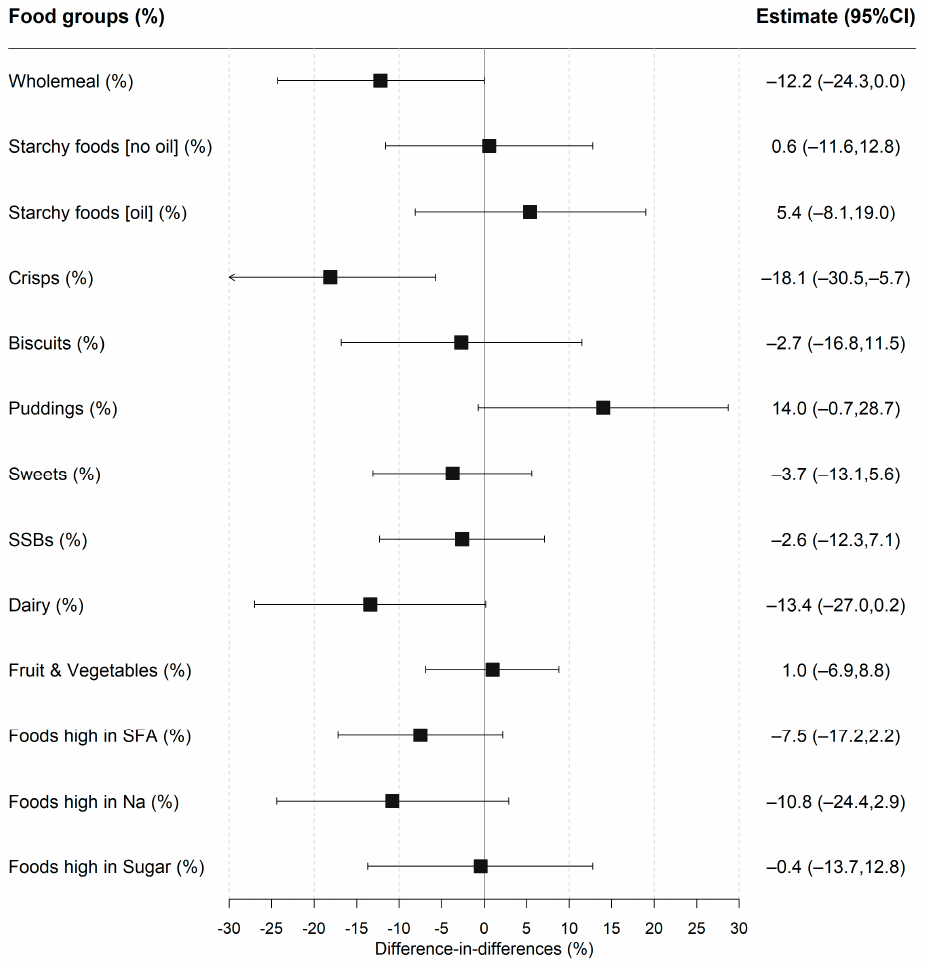
Figure 1. Difference-in-differences estimates of UIFSM policy impact on the likelihood of consuming a food group. Note: SSBs—sugar-sweetened beverages, SFA—saturated fats, and Na—sodium. Linear probability regression adjusted for age, sex, ethnicity, household size, region, household income, IMD and total lunchtime intake. Pre/Post prevalence of consuming food groups presented in Table S3. Coefficients represent percentage point change in likelihood of consuming a food group.